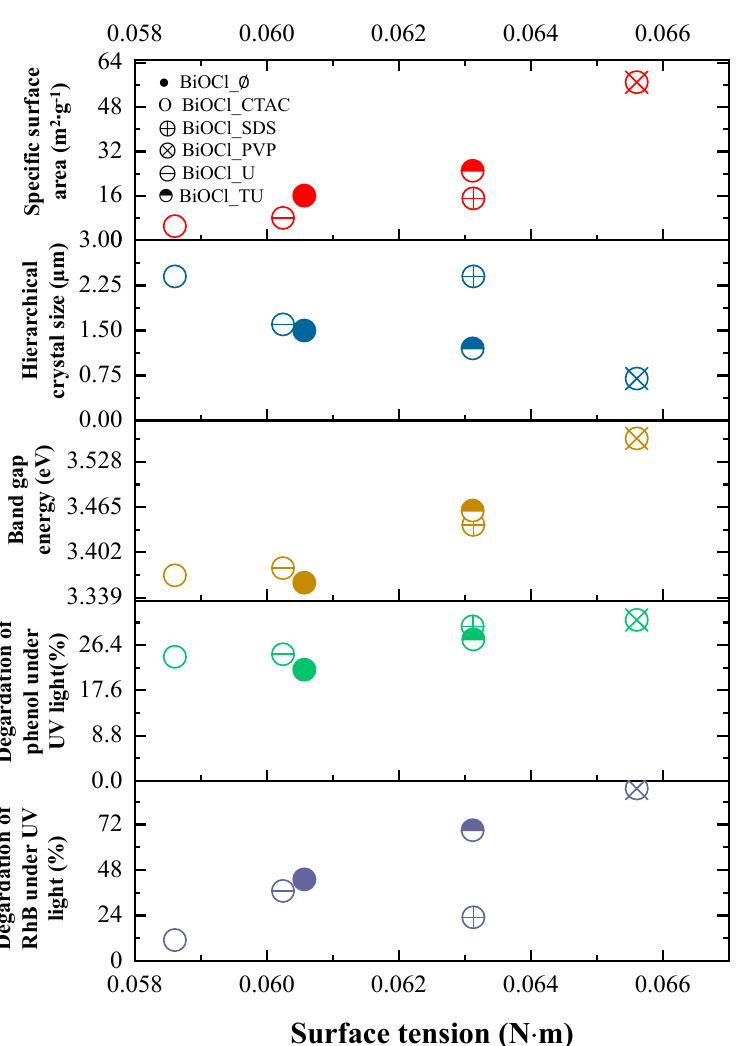
Figure 5. The influence of the surface tension on specific surface area (red), hierarchical crystal size (blue), band gap energy (brown), and the degradation of phenol (green) and RhB (purple) under UV irradiation .